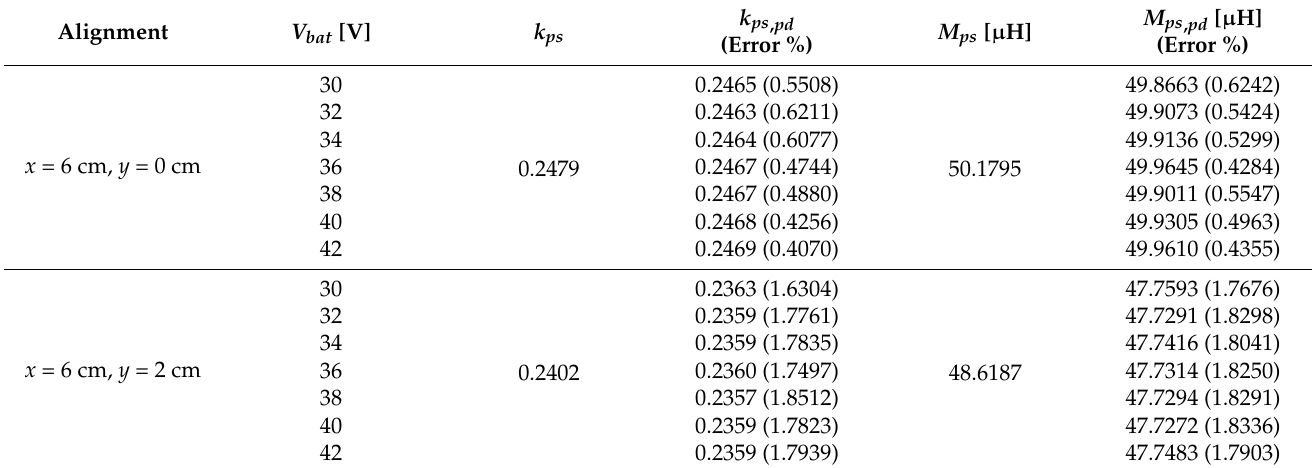
Table 2. Prediction results of k ps and M ps in the range of V bat = 30~42